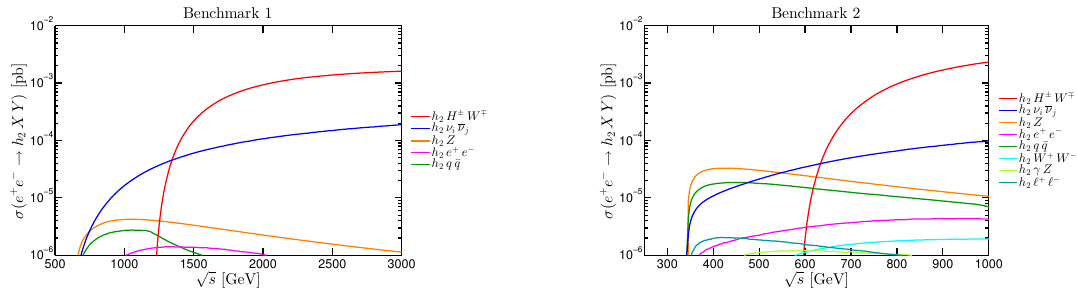
Figure 6 . Two and three body production cross section for h 2 in an electron-positron collider as p a function of s for both